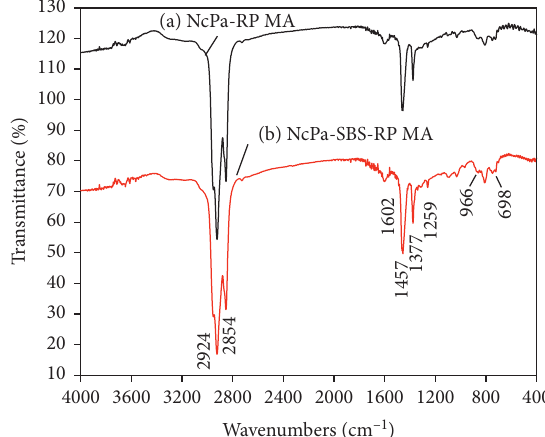
Figure 16: FTIR spectra of the nanocarbon/rubber powder- modified asphalt and nanocarbon/SBS/rubber powder-modified asphalt.